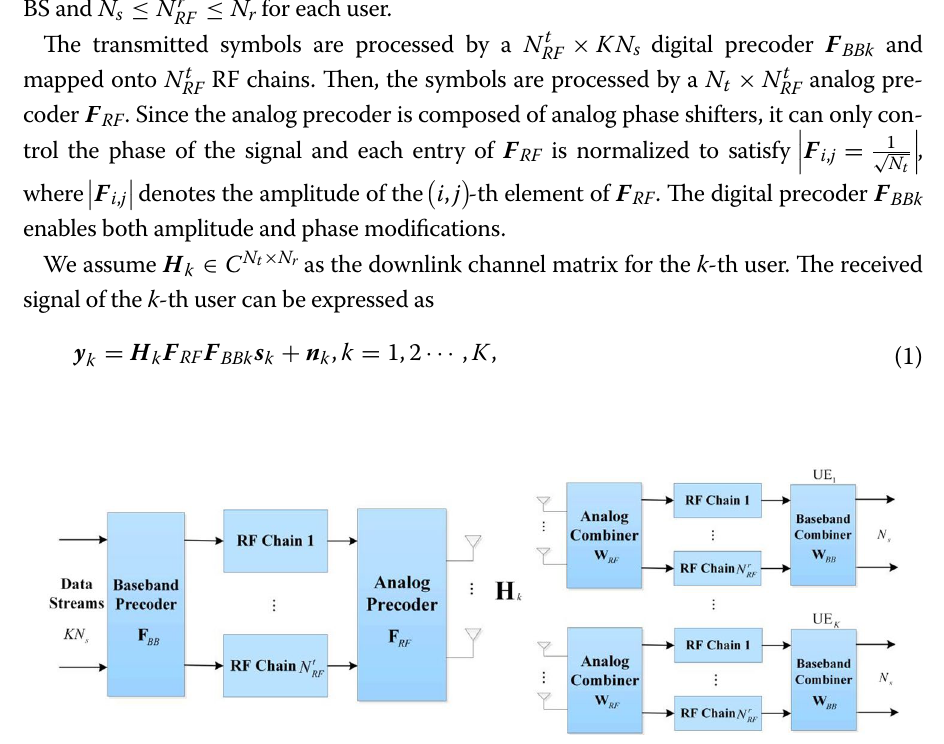
Fig. 1 System model of multi-user hybrid